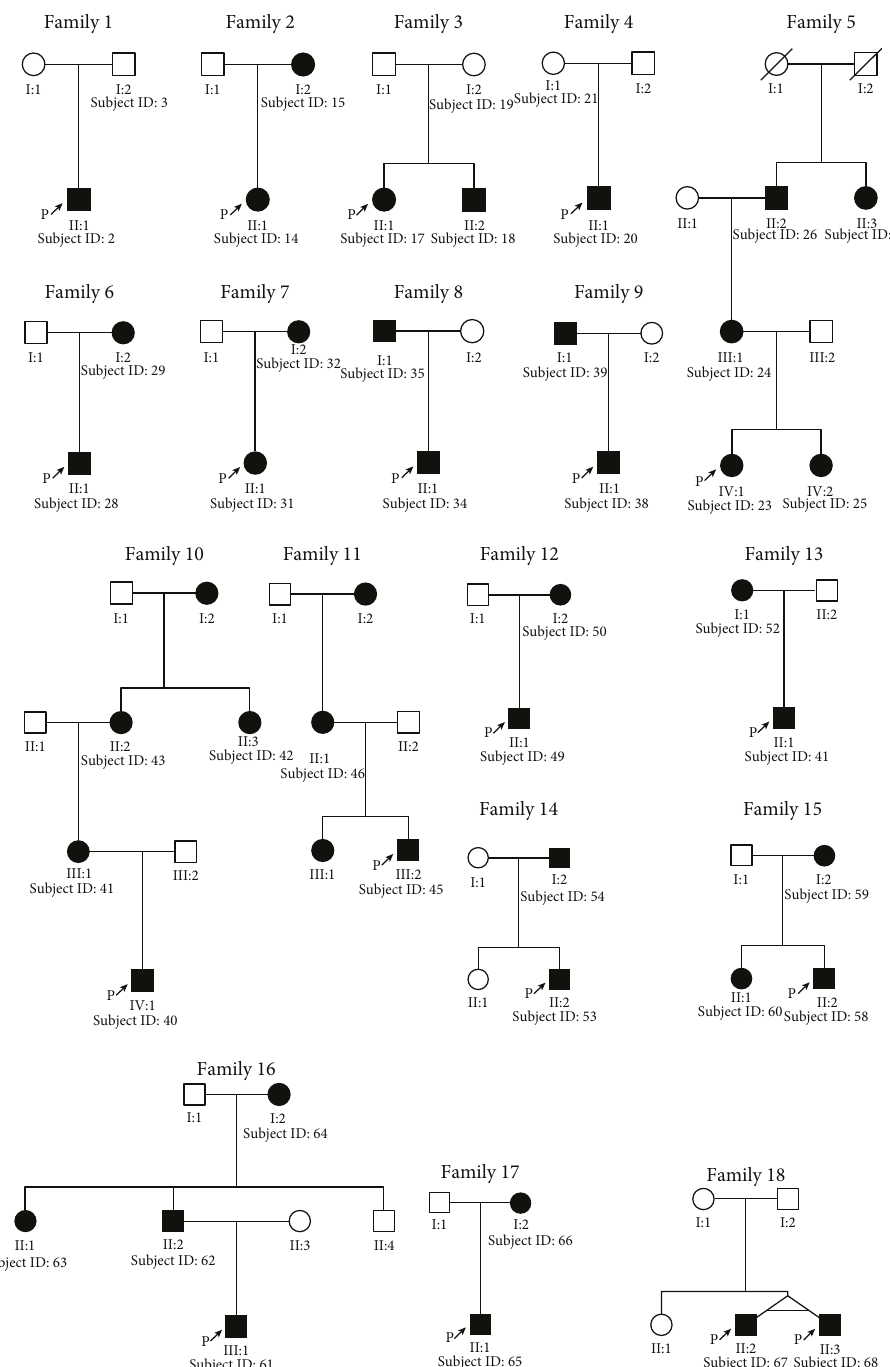
Figure 1: Eighteen WS families with at least 2 DNA samples and clinical information collected in the study. Family ID and Subject ID were added to the individuals with DNA samples. A table with all data for family cases was shown in Table